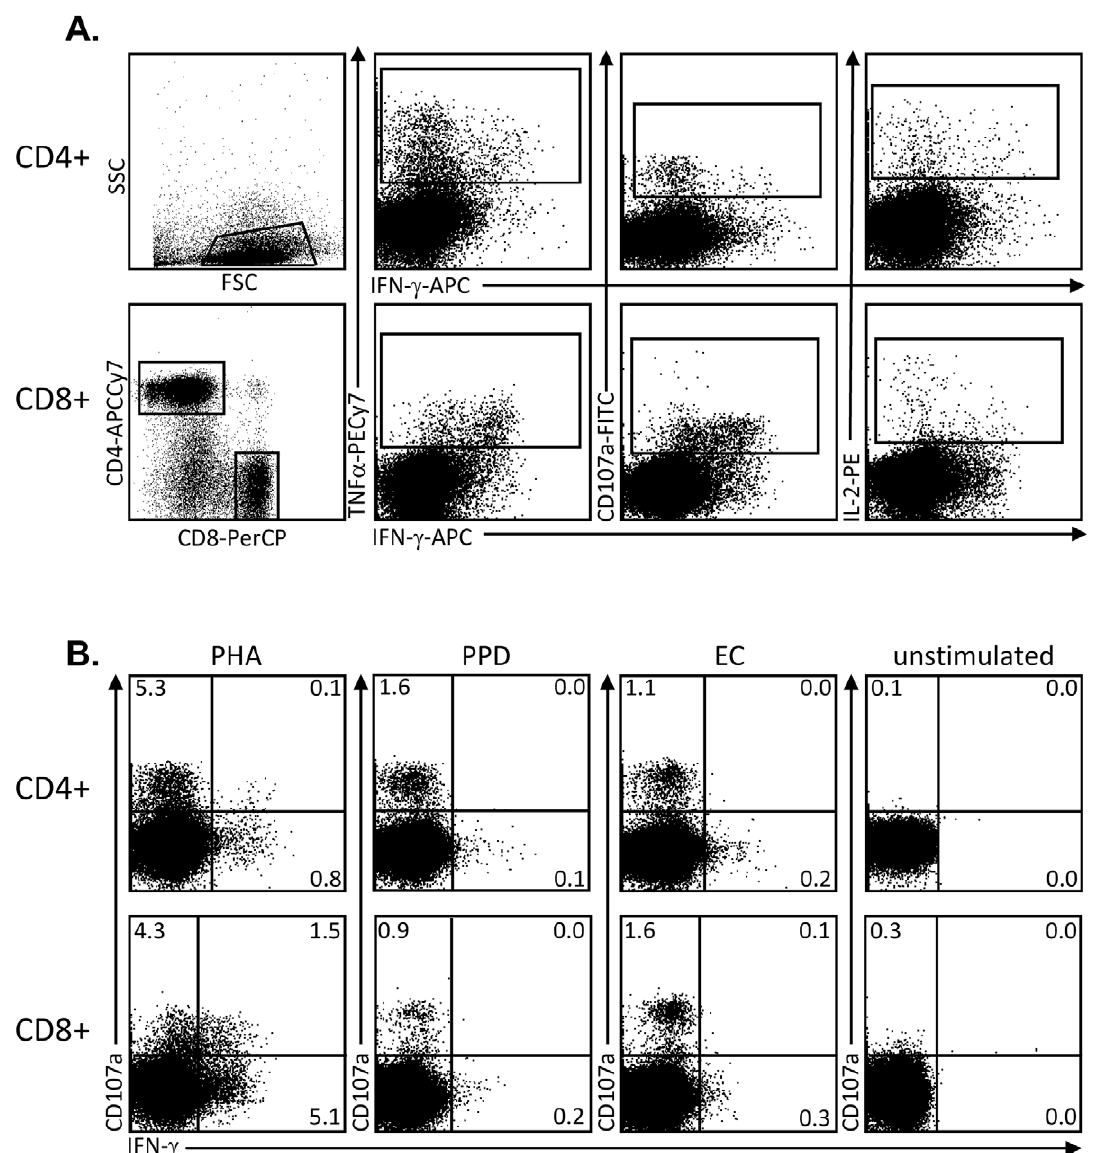
Figure 1. Representative flow cytometry profiles demonstrating the gating strategy used throughout the study. A) PBMC were stimulated overnight and cells were analysed by flow cytometry for expression of CD107a, TNF- a , IL-2 and IFN- c . Following lymphocyte gating, CD4 + and CD8 + T cells were analysed separately for combinations of all 4 factors. B) Representative dot plots illustrating cytokine production from CD4 + and CD8 + T cells following PHA, PPD, EC and no